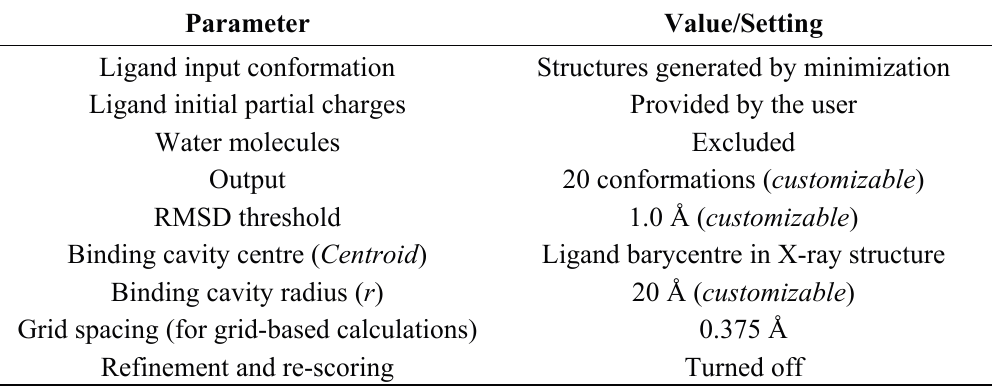
Table 3. Common docking settings for the evaluated